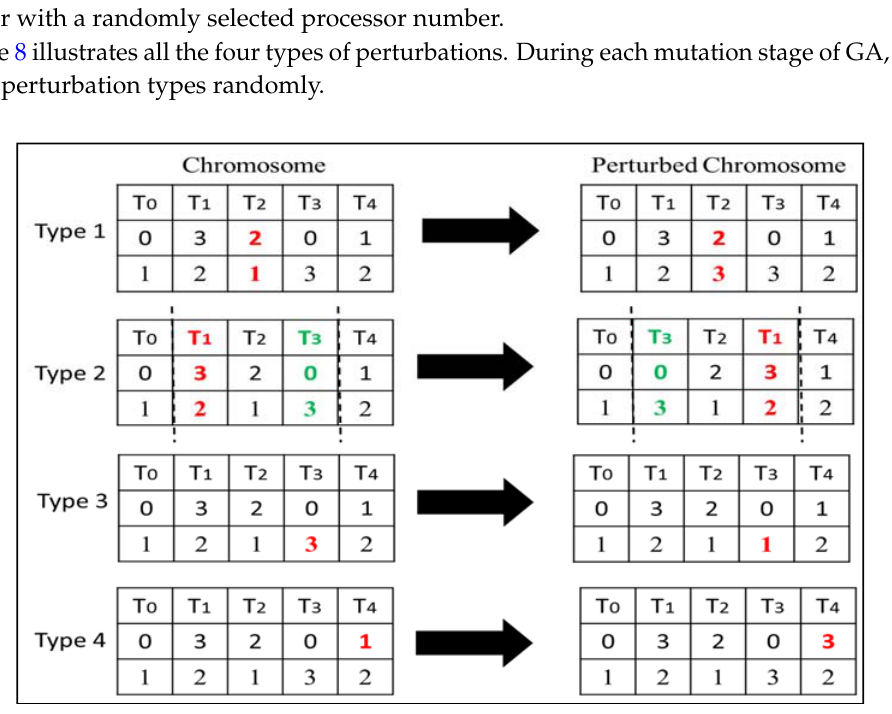
Figure 8. Different types of perturbations.